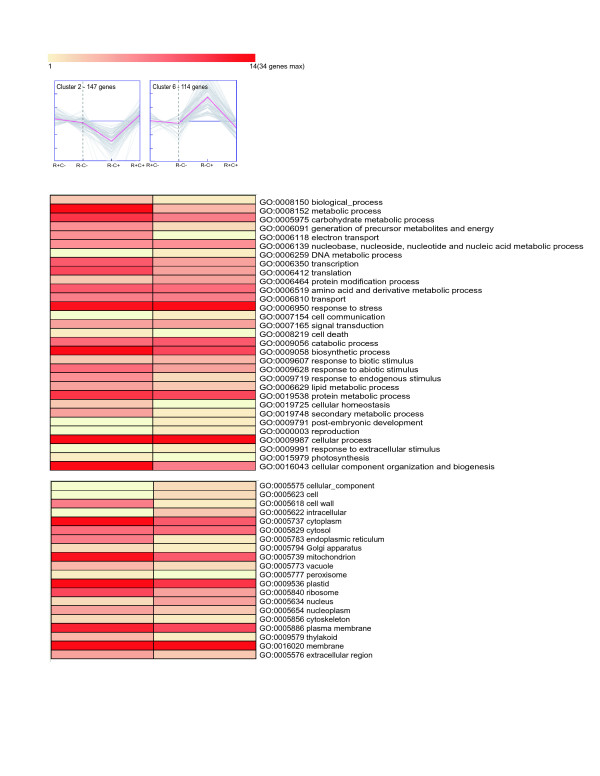
Gene clusters with inverse expression profiles exclusively in fruits that have undergone long-term cold storage. Cluster 2 (left) contains 147 genes that have reduced expression exclusively in fruits that have undergone long-term cold storage (E3: R-, C+), whereas cluster 6 (right) contains 114 genes with increased expression exclusively in these same fruits. The Gene Ontology annotations of the genes in these clusters are represented below each cluster. The number of genes associated with each GO term is represented by the color of the bars, as depicted in the scale presented in this figure. The dashed line indicates non-ripe fruits, E1 (R-, C-). To the left of the dashed line is the expression levels for ripe, juicy fruits, E2 (R+, C-). To the right of the dashed line are E3 (R-, C+) and E4 (R+, C+) fruits, non-ripe and ripe fruits that have undergone long-term cold storage, respectively. E4 (R+, C+) fruits are wooly. GO annotations correspond to the parental plant GO Slim terms.